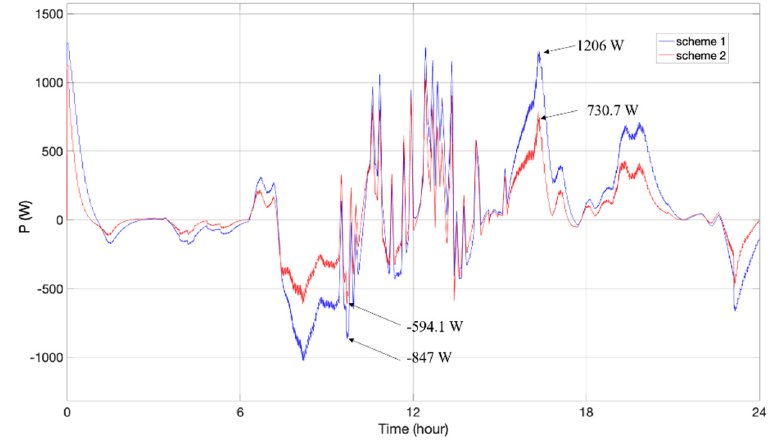
Figure 24. Supercapacitors assumed power comparison.